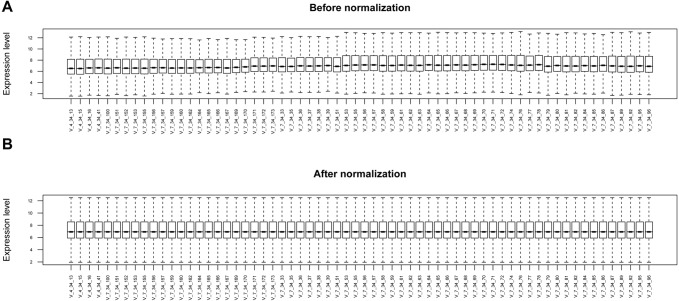
The box plots before and after data normalization.